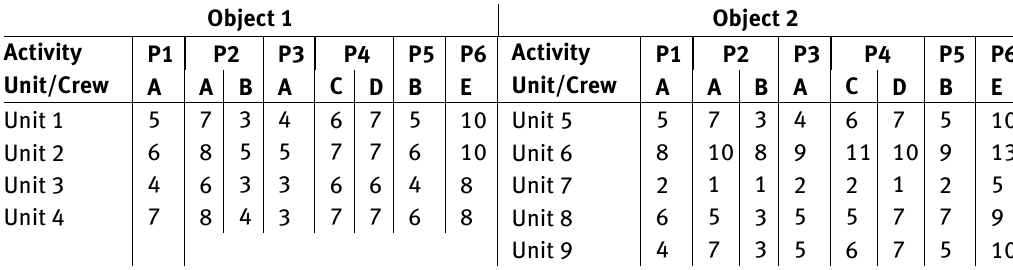
Table 3: Execution times of activities by crews on objects and construction units expressed in